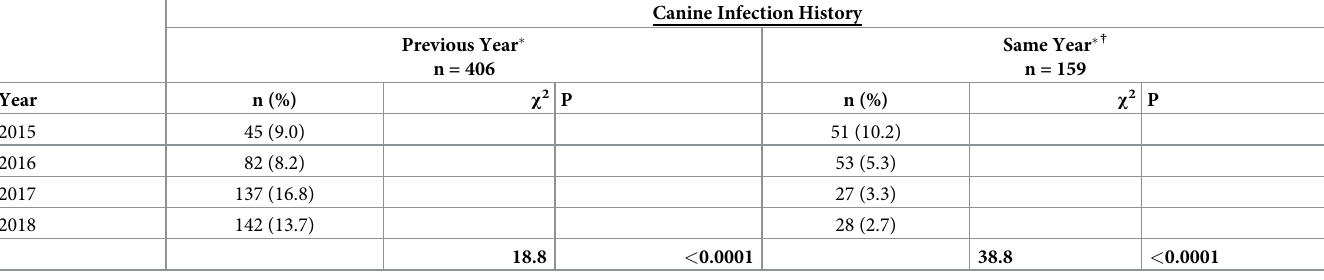
Bold indicates statistical significance. � Missing values for previous year = 11, missing values for same year = 9. † Only includes dogs that had worms not detected by the surveillance system (as reported by